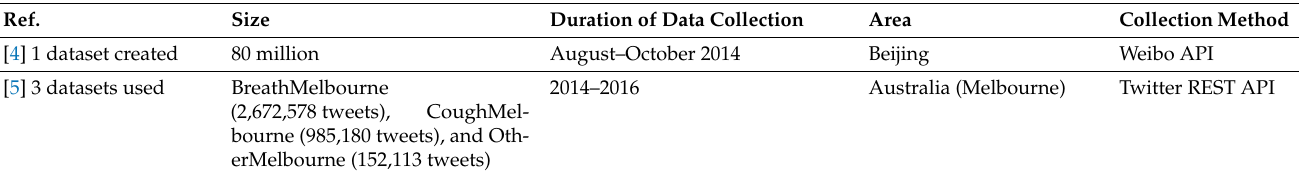
Table 4. Shallow-ML-based articles’ used datasets and their related information: presenting total datasets created, size of datasets, duration of data collection, geographical area, and their collec- tion